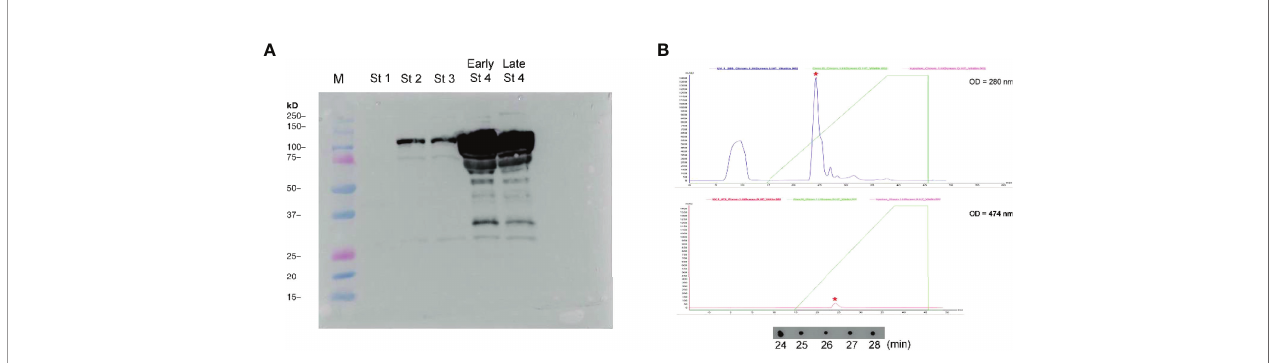
FIGURE 4 | (A) Validation of anti-MrVn in probing the Vn subunits of the S. olivacea , lane M referred to molecular ladder, St1-Late St4 referred to the ovary samples taken from stage 1 to late stage 4, respectively. (B) Chromatogram of ovarian extract of S. olivacea as fractionated by ion exchange FPLC on a HiScreen ™ Q HP columns and monitored at wavelengths of 280 nm and 474 nm, respectively. Asterisk showed the immunoreactive peak whose fractions (24-28 min) were con fi rmed by dot blot with anti-MrVn.